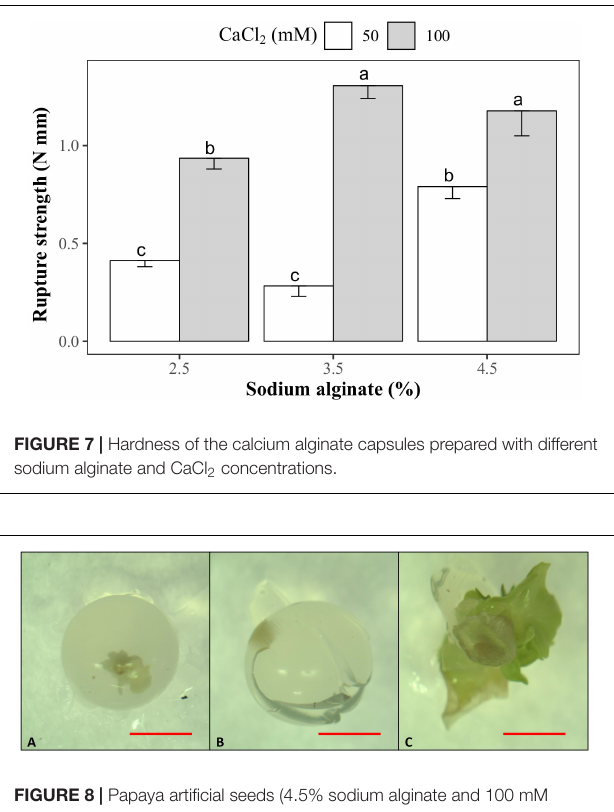
FIGURE 8 | Papaya artificial seeds (4.5% sodium alginate and 100 mM CaCl 2 ) with or without a treatment with 200 mM de KNO 3 for 20 min ( A,B , respectively), and sprouted seed after 12 weeks of culture (C) . Bars equal 3